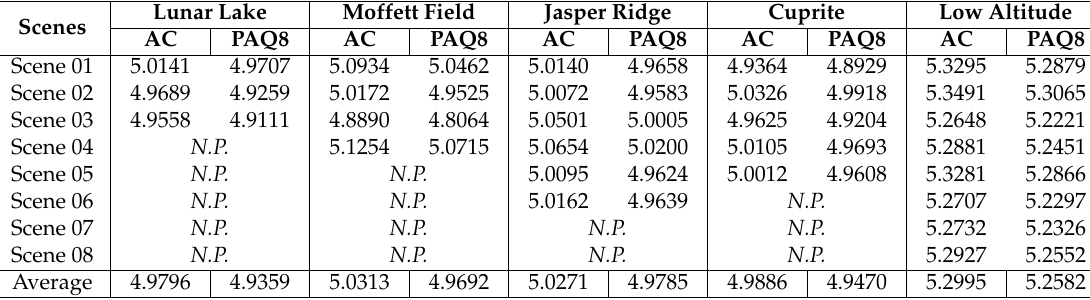
Table 4. Achieved results by using the following parameters: N “ 8, B “ 2.